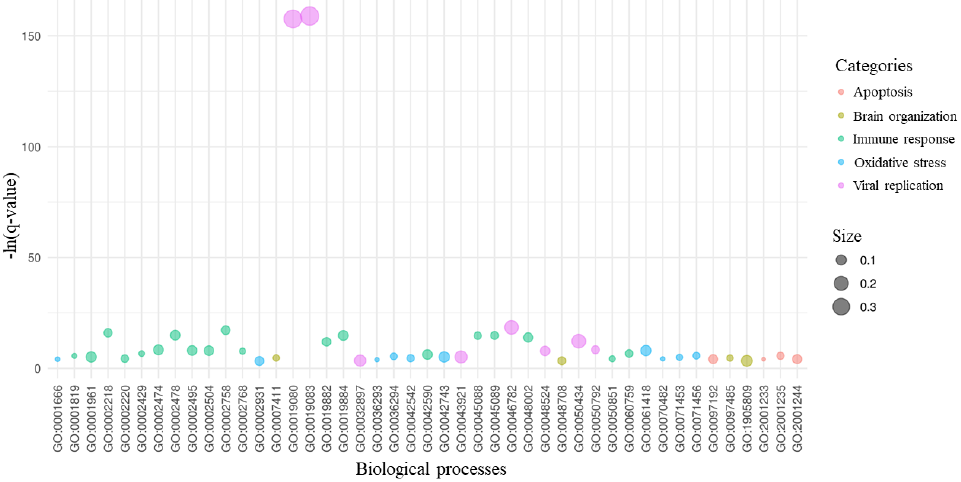
Figure 4. Biological processes of the key DEGs. For the 21 DEGs with the highest betweenness cen- trality and their 244 interactors, we provided the gene ontology enrichment of their biological pro- cesses. Among all the statistical significant processes, we kept the 45 processes related to apoptosis, brain organization, immune response, oxidative stress and viral replication, as shown in the legend. On the x -axis, we listed the gene ontology IDs of all the 45 processes. For each process, the score in the y -axis highlights its level of significance as -ln( q -value). The size of each bubble is proportional to the amount of DEGs implicated in the process compared to the number of genes that are